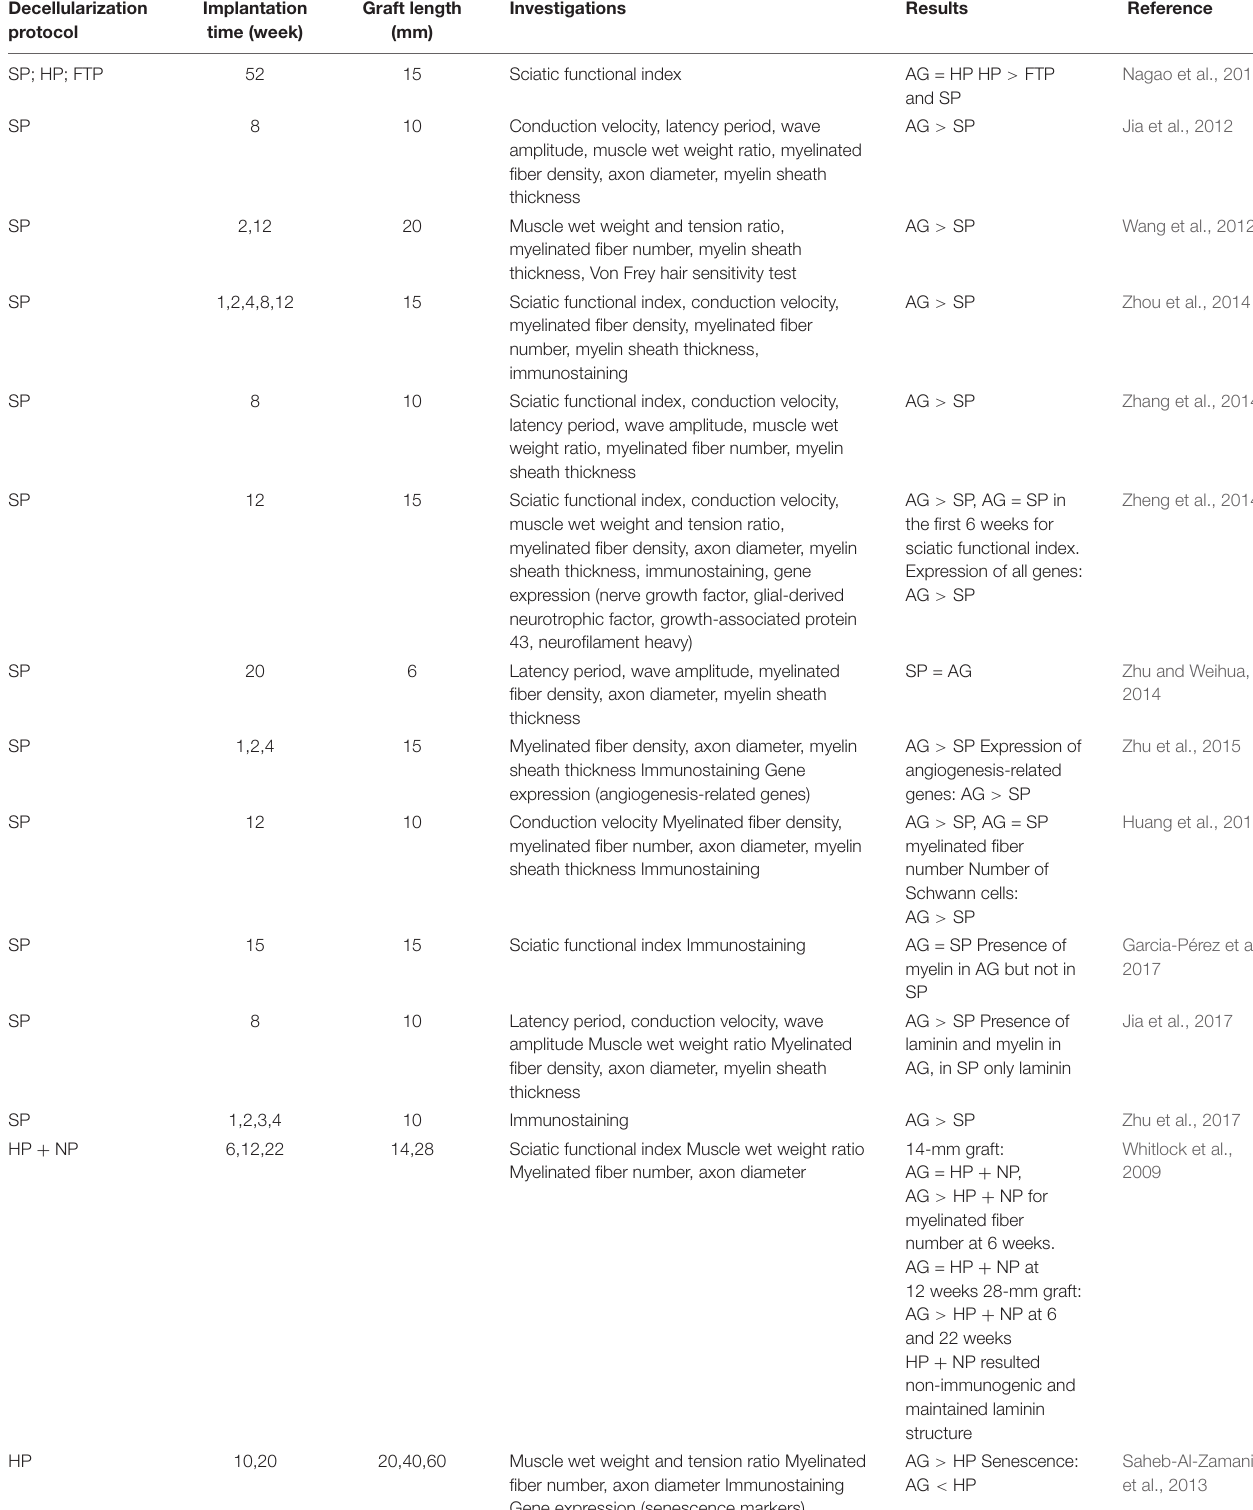
TABLE 1 | In vivo studies of nerve tissue decellularization and graft implantation. Decellularization